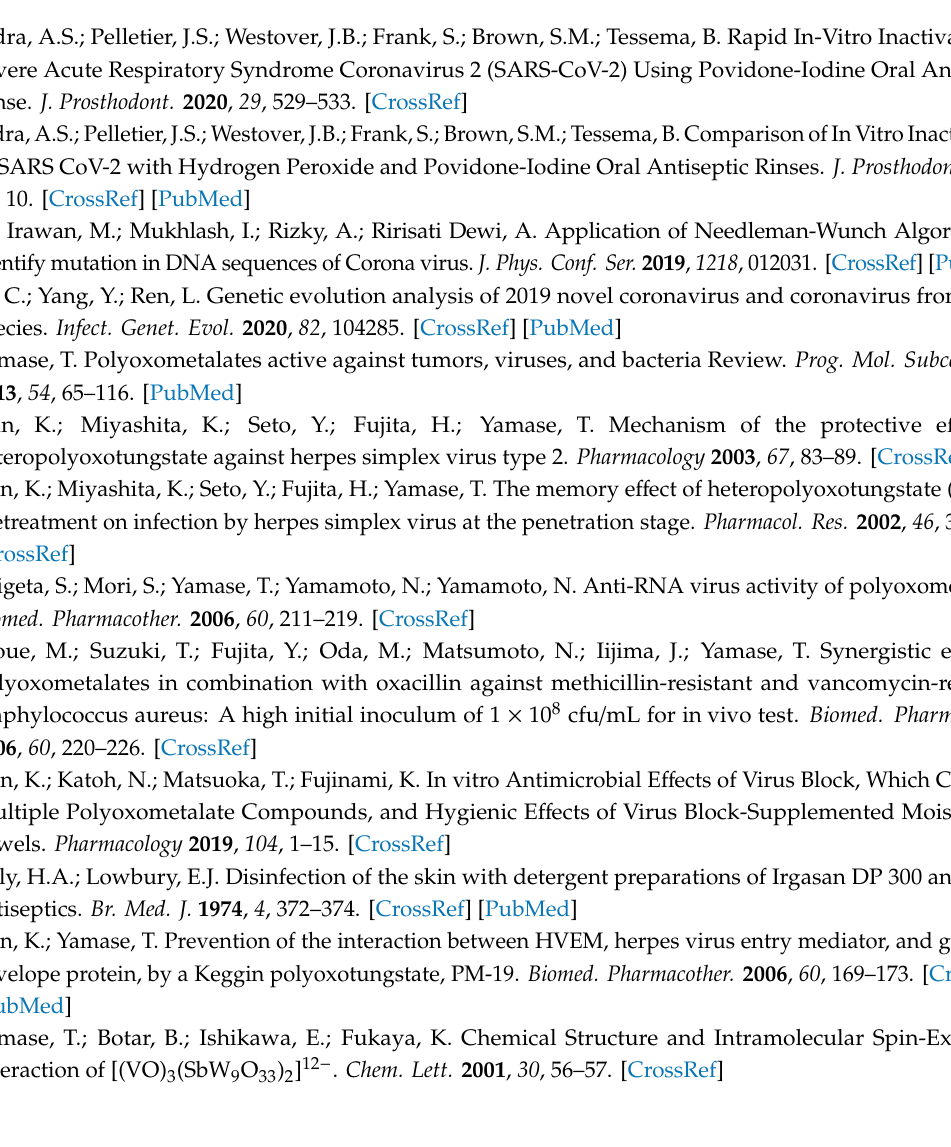
Figure S1: Negative testing of commercial hygiene products, Figure S2: Stationary fitting